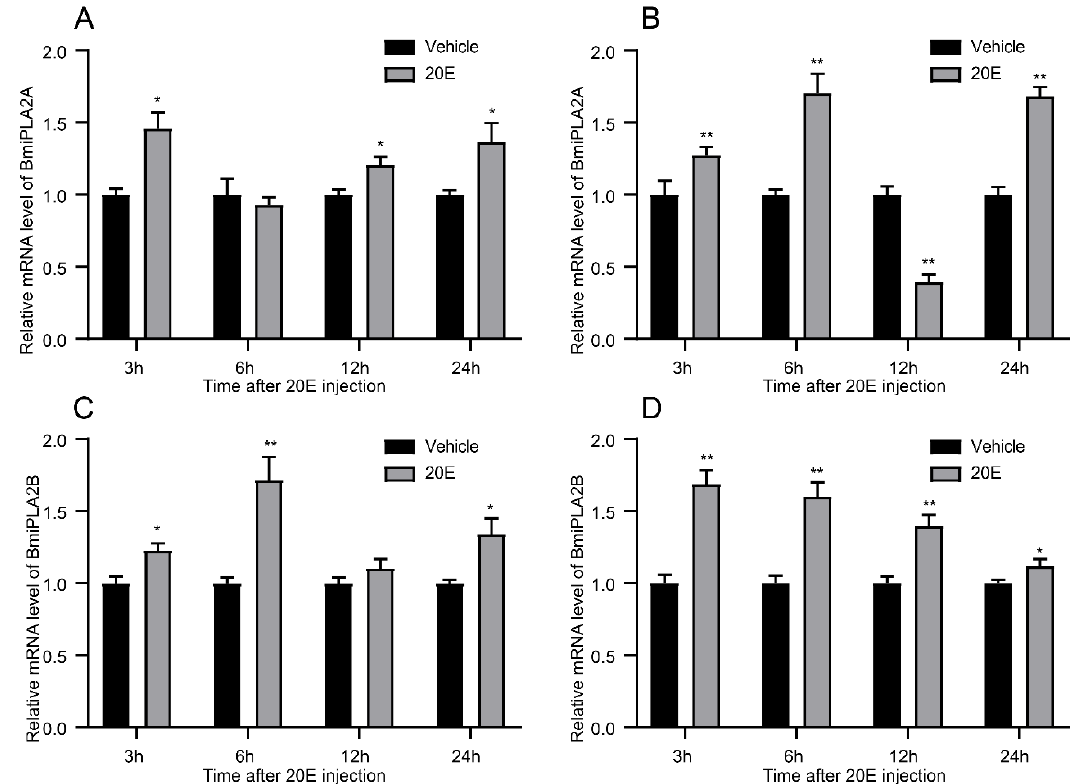
Figure 7. Expression of BmiPLA2A in hemocytes ( A ) and epidermis ( B ) of 20-E (20-hydroxyecdysone) induced silkworm larvae, and expression of BmiPLA2B in hemocytes ( C ) and epidermis ( D ) of 20-E (20-hydroxyecdysone) induced silkworm larvae. The asterisks indicate the significance was statistically significant or extremely significant (* p <0.05, ** p <0.01 and *** p <0.001).